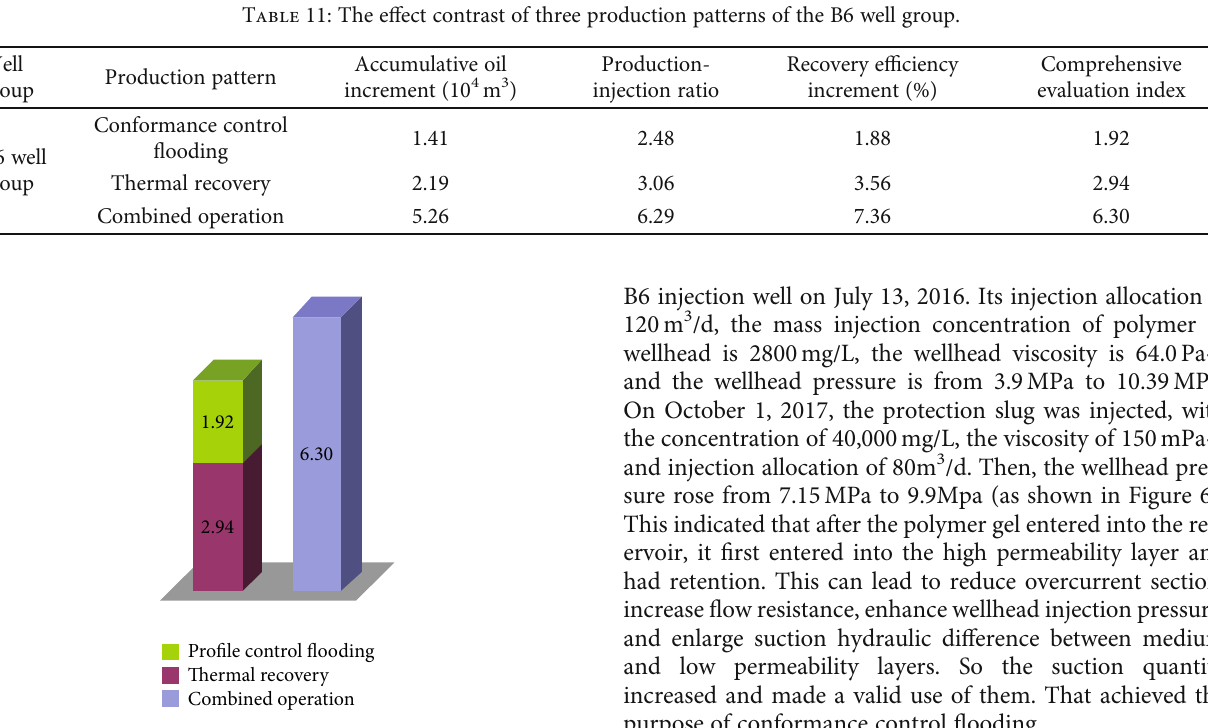
Figure 5: The comprehensive evaluation index of three production patters of the B6 well